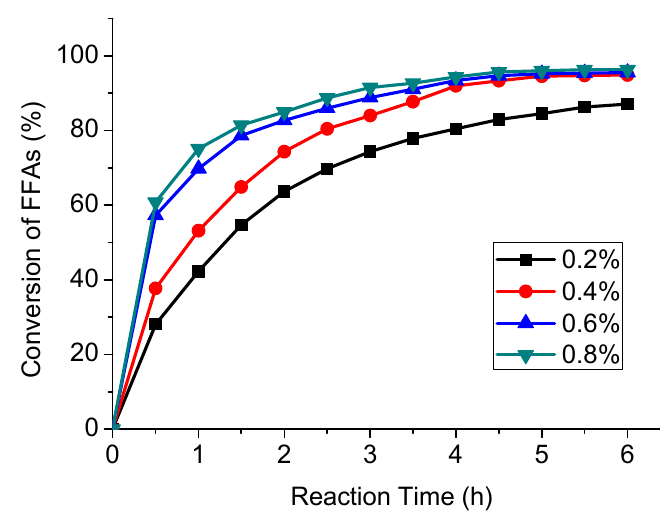
Figure 2. Effect of the amount of sulphuric acid on the